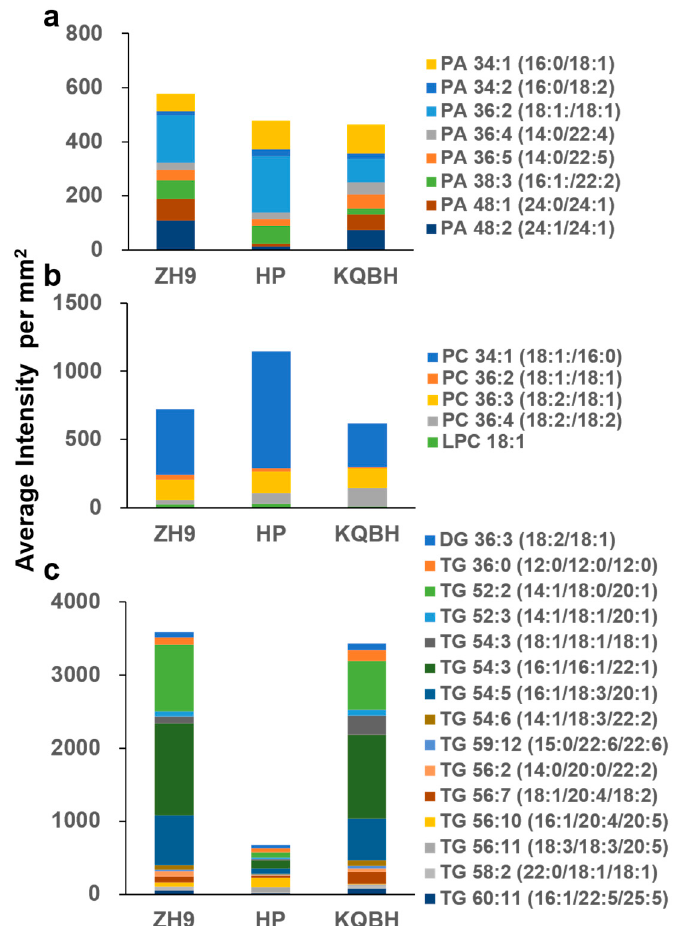
Figure 3. The stacked column chart showed the average intensity of ( a ) phosphatidic acids, ( b ) phos- phatidylcholines, and ( c ) triacylglycerols by MALDI-MSI from different peanut seeds. A whole tissue section was selected as a region of interest. The average intensity per mm 2 represents the relative abundance of lipid species.